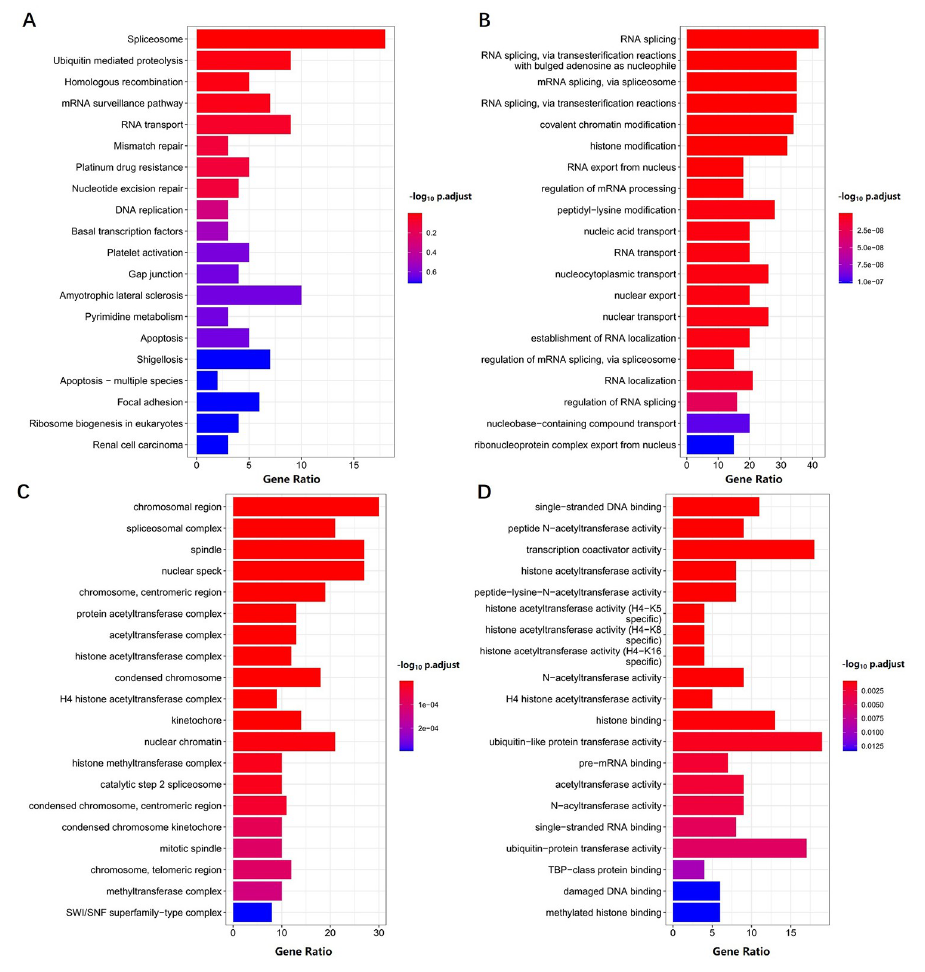
Fig 5. Functional enrichment analyses of differentially expressed genes (DEGs) in high- and low- UPF3B expression LIHC samples. KEGG (A)and Gene Ontology (GO) analyses, including biological process (B), cellular component(C) and molecular function (D) were performed by clusterProfiler R package. Data was obtained via TCGA. P value < 0.05 was considered statistically